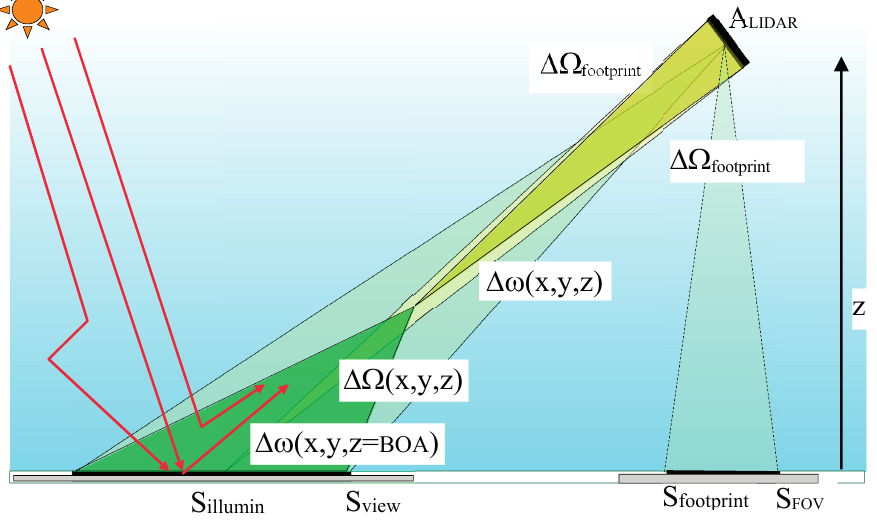
Figure 11. The LIDAR geometry configuration, with horizontal ground